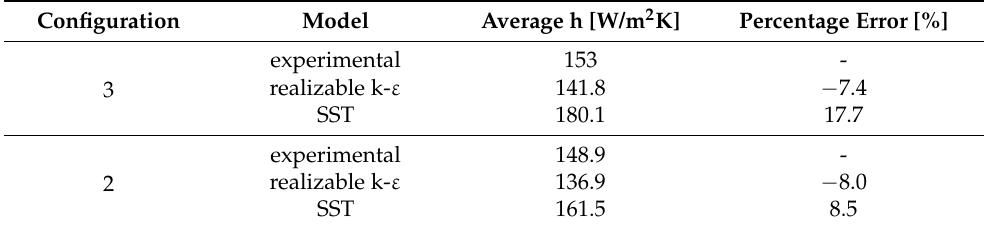
Table 6. Average heat transfer coefficient and percentage errors of the CFD models with respect to experimental values of the multi slot jet configurations for H/B = 16.